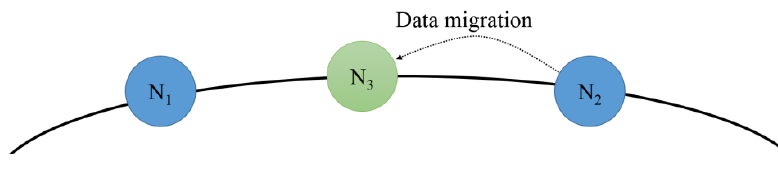
Figure 10. Assigning a hash value to the underloaded node.